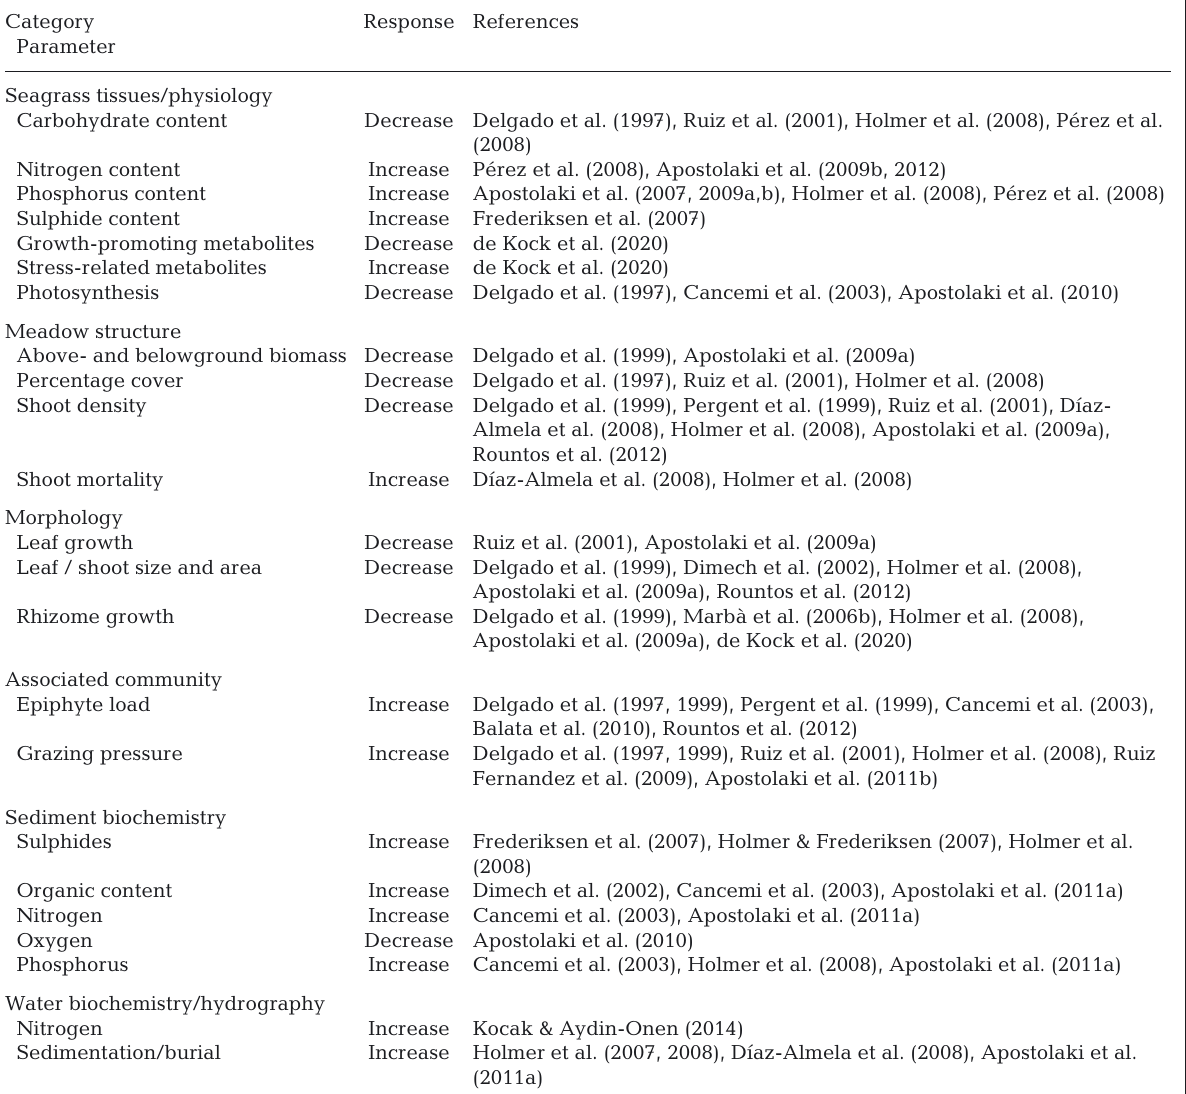
Table 2. Overview of published responses of Posidonia oceanica and Cymodocea nodosa meadows to open net-pen finfish aquaculture in the Mediterranean